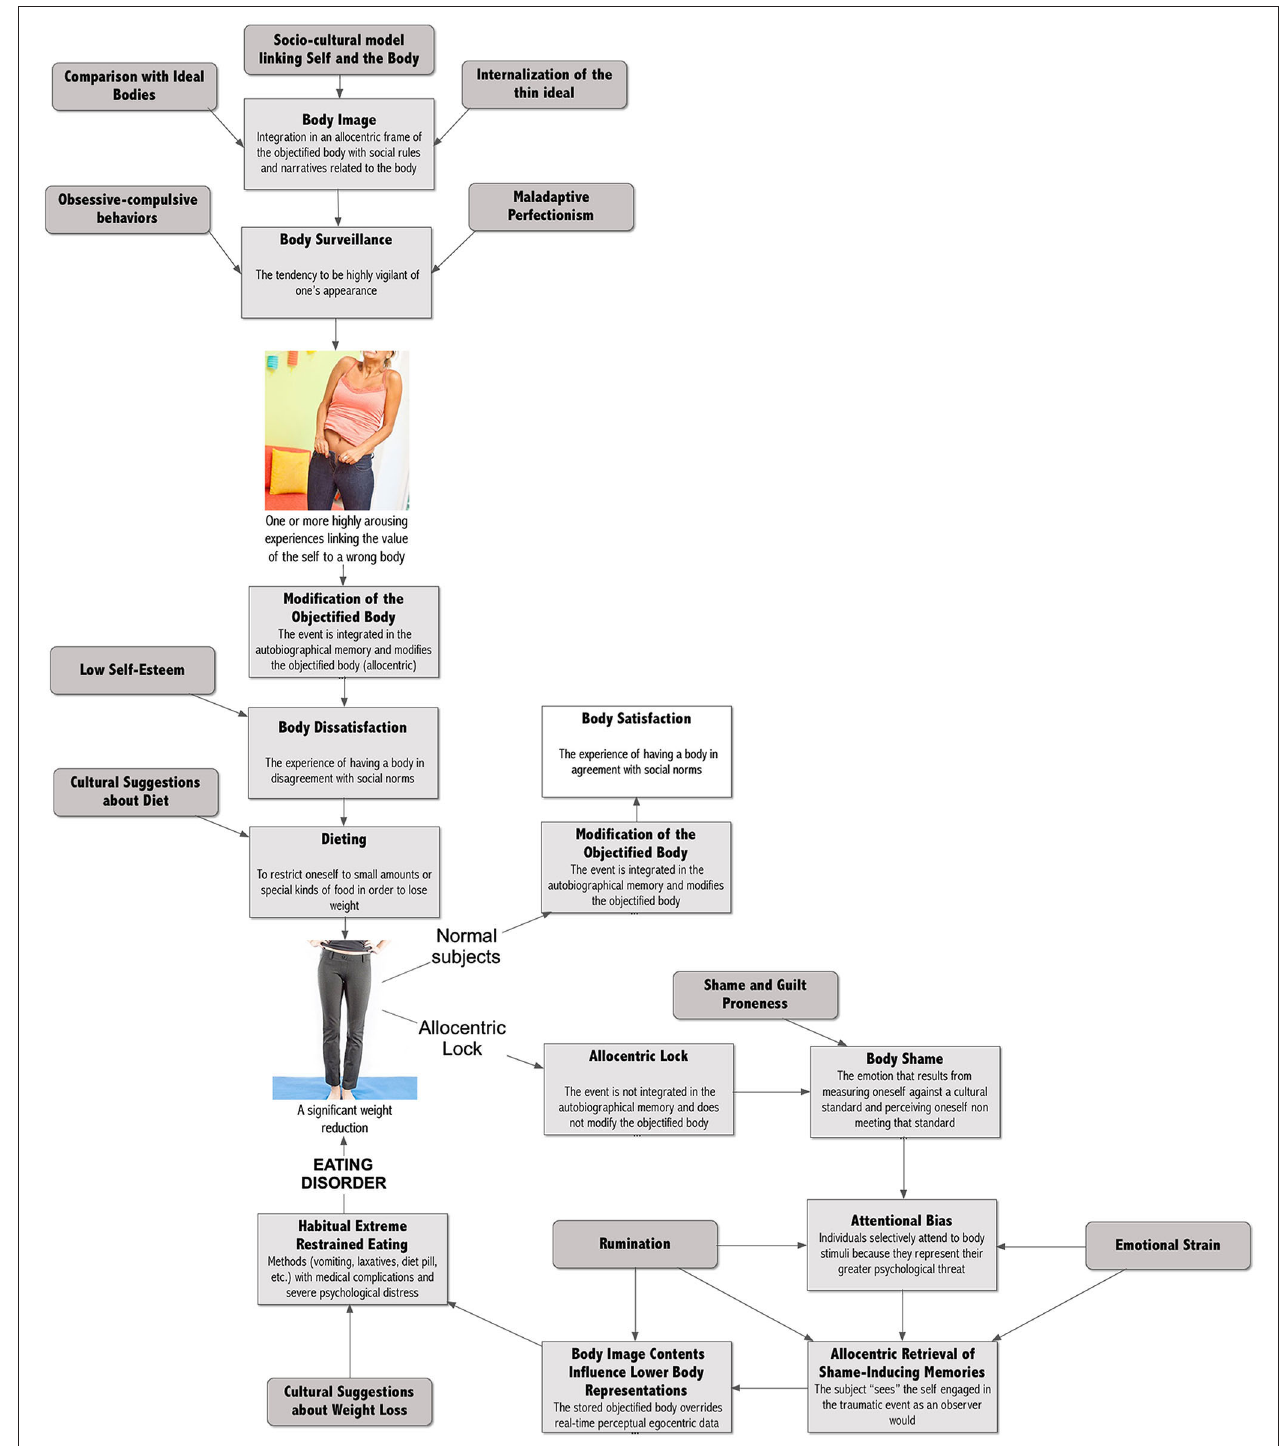
FIGURE 2 | From culture to eating disorders